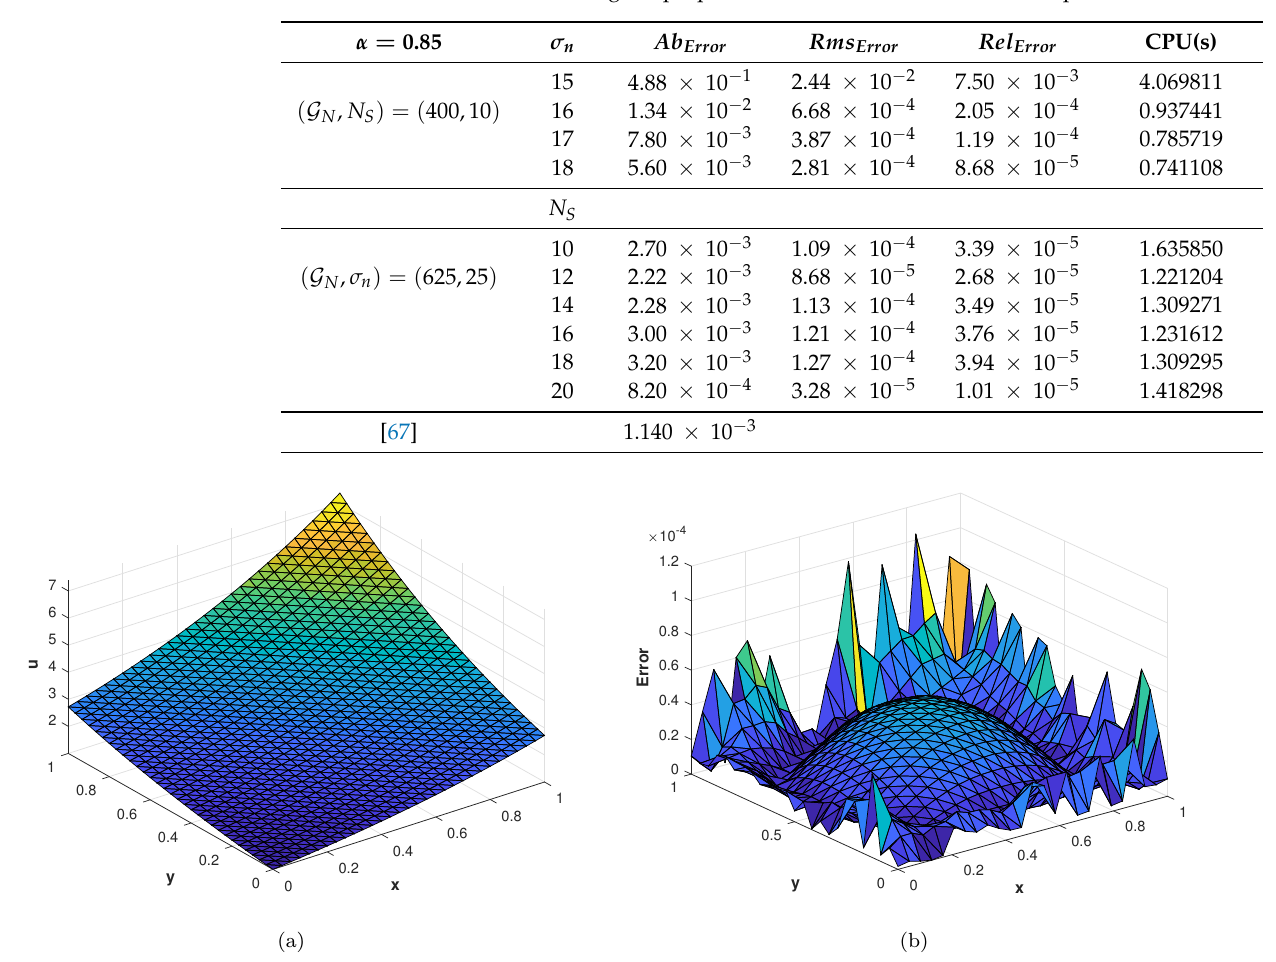
Table 2: The errors obtained using proposed scheme at final time T = 1 for problem 2 α = 0 . 85 Table 2. The errors obtained using the proposed scheme at final time T = 1 for problem 2.